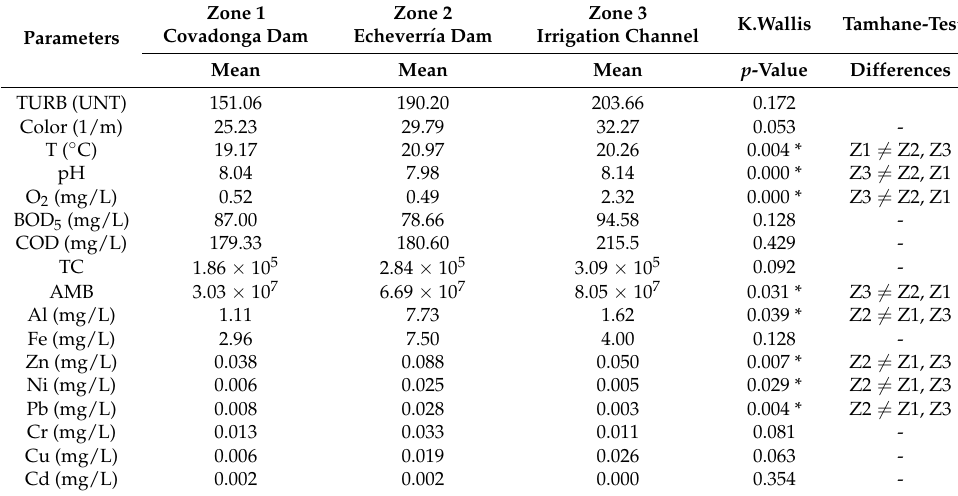
Table 3. Increase pattern in BOD 5 and COD organic contamination and bacteriological from Covadonga Dam (Z1) to EPG